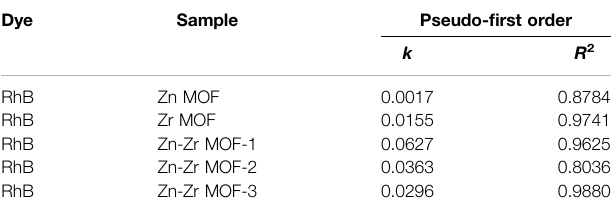
TABLE2| Kineticparametersofthepseudo- fi rstorderforRhBdegradationunder visible light irradiation. Dye Sample